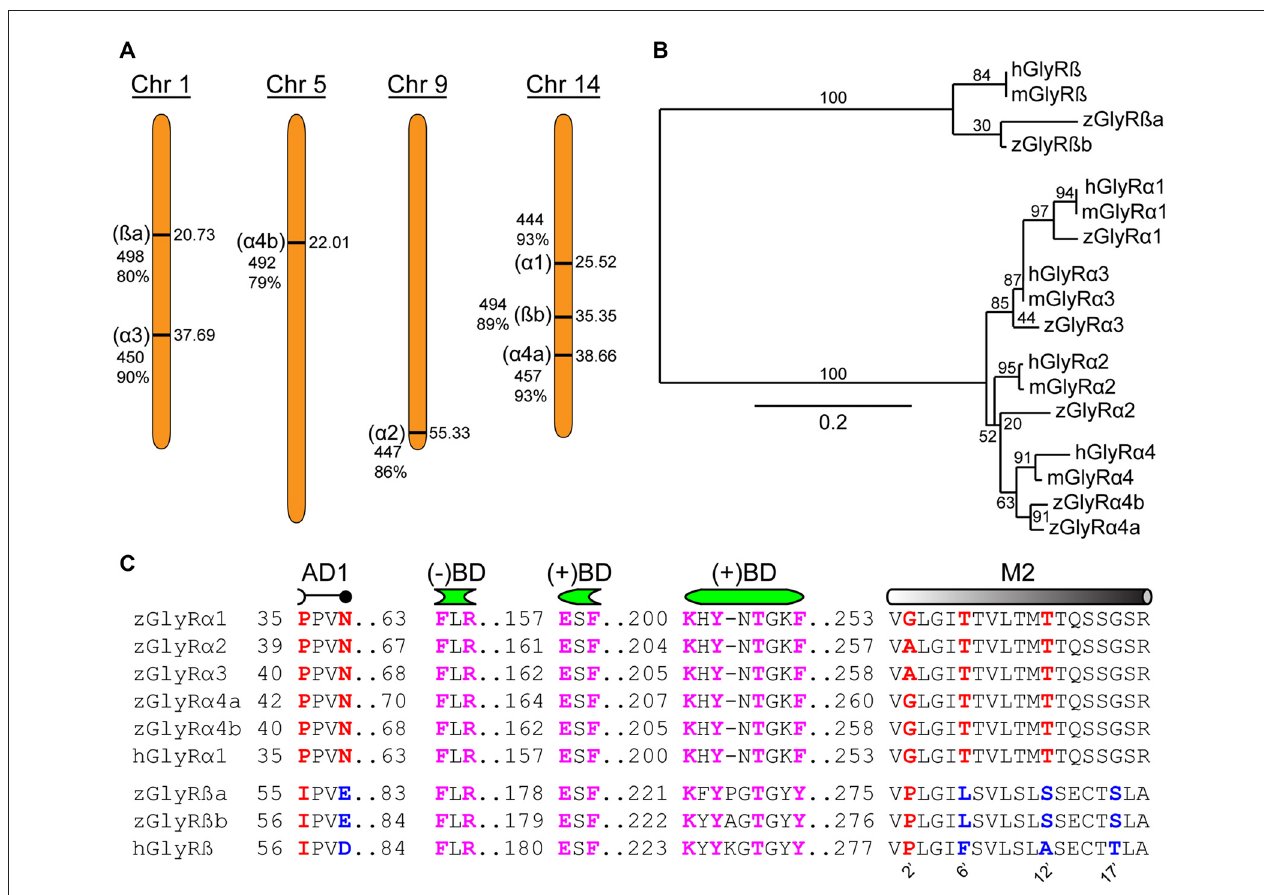
FIGURE 1 | Zebrafish family of glycine receptors (GlyR). (A) Chromosomal (Chr) arrangement of zebrafish GlyR (zGlyR) subunits. Location (in Mbp) are on the right, while name of subunit, length and sequence similarity to human ortholog are given to the left. (B) Phylogenetic analysis of zGlyR subunits. Horizontal scale bar at the bottom reflects amount of genetic change, all other numbers are bootstraps. (mGlyR and hGlyR) mouse and human GlyR subunit. (C) Sequence alignments of zGlyR α subunits to hGlyR α 1, and zGlyRß subunits to hGlyRß. Red letters indicate residues conserved among α and ß subunits from zebrafish and human. Blue letters indicate residues conserved between zGlyRß paralogs which differ from hGlyRß. Magenta letters indicate residues conserved between α and ß subunits from zebrafish and human. AD1: assembly domain one, ( − )BD and (+)BD: negative and positive faces of the inter-subunit binding sites for glycine and strychnine, M2: transmembrane domain 2. Numbered residues (‘) indicate position with